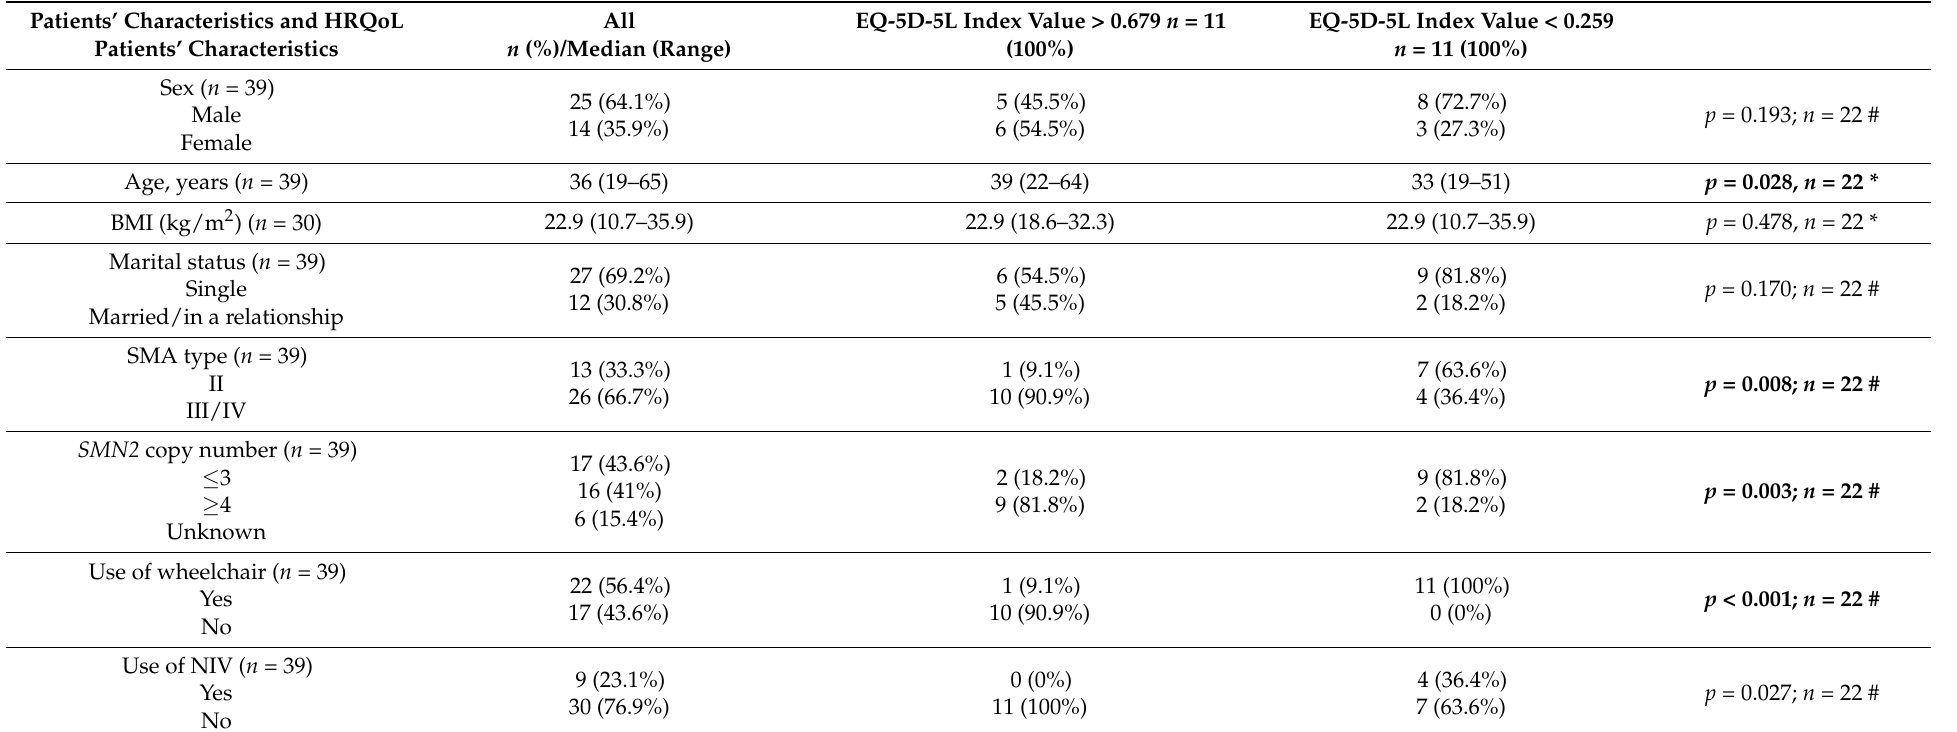
Table 1. Patients’ characteristics and HRQoL: This table shows the demographic and clinical characteristics of all patients participating in the HRQoL analysis. The patients were dichotomized into high- and low-HRQoL groups according to their EQ-5D-5L index value (>0.679 or <0.259). Statistical parameters printed in bold type indicate statistically significant differences between the high- and low-HRQoL groups. * indicates that a Mann–Whitney U Test was performed. # indicates that either chi-Square or Fisher’s exact tests were performed. Abbreviations: EQ-5D-5L = EuroQoL Five Dimension Five Level Scale; HRQoL = health-related quality of life; n = number; BMI = Body Mass Index; SMA = spinal muscular atrophy; SMN2 = survival motor neuron 2 gene; NIV = non-invasive ventilation; PEG = percutaneous endoscopic gastrostomy; ALSFRS-R = Amyotrophic Lateral Sclerosis Functional Rating Scale Revised; RULM = Revised Upper Limb Module; HFMSE = Hammersmith Functional Motor Scale Expanded; ADI-12 = ALS-Depression Inventory-12; VAS = Visual Analogue Scale; SF-36 = Short Form Health Survey